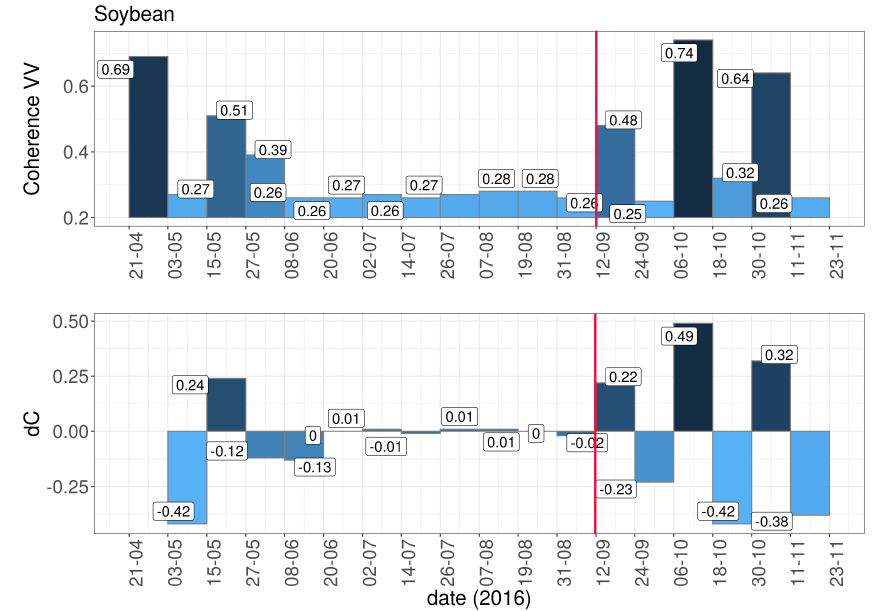
Figure 7. Examples of VV coherence time series and its first differences ( dC ) for soybean fields (Ukraine), harvesting: 31 August–12 September